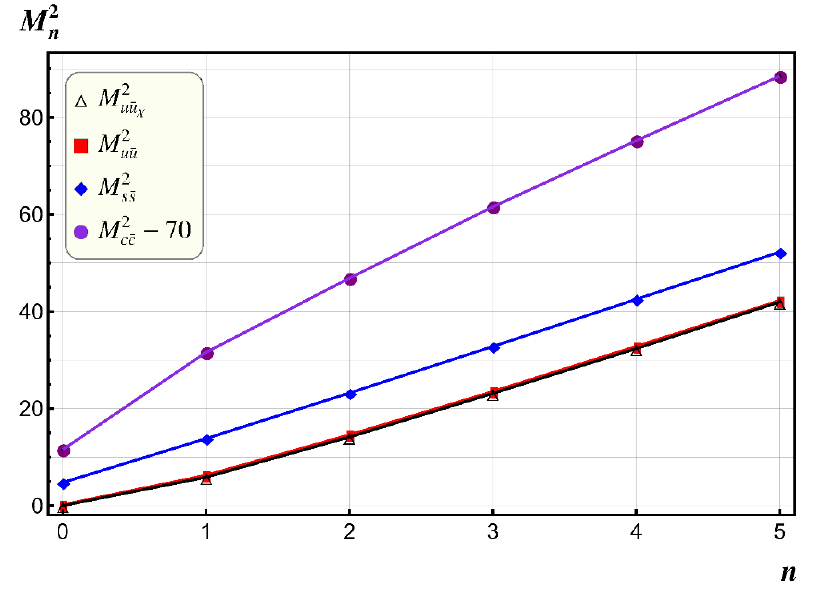
Figure 6 . Mass spectra of a few low-lying mesonic levels with di(cid:11)erent quark